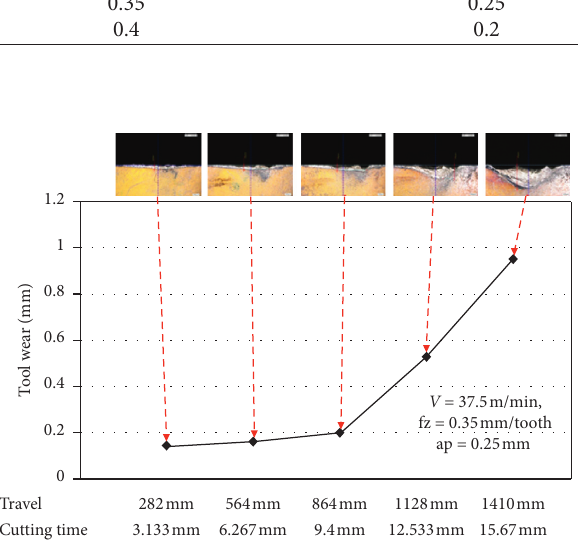
Figure 8: Tool wear under conditions of V � 37.5m/min, fz � 0.35 mm/tooth, and ap � 0.25